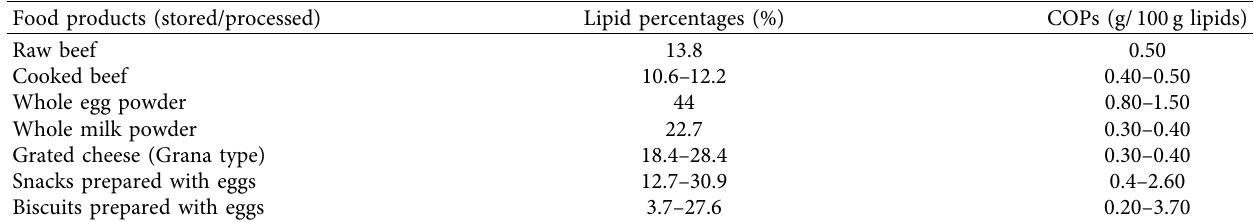
Table 1: Lipid contents of various food products and the amount of COPs